Question: What does this figure show? Answer in one sentence.
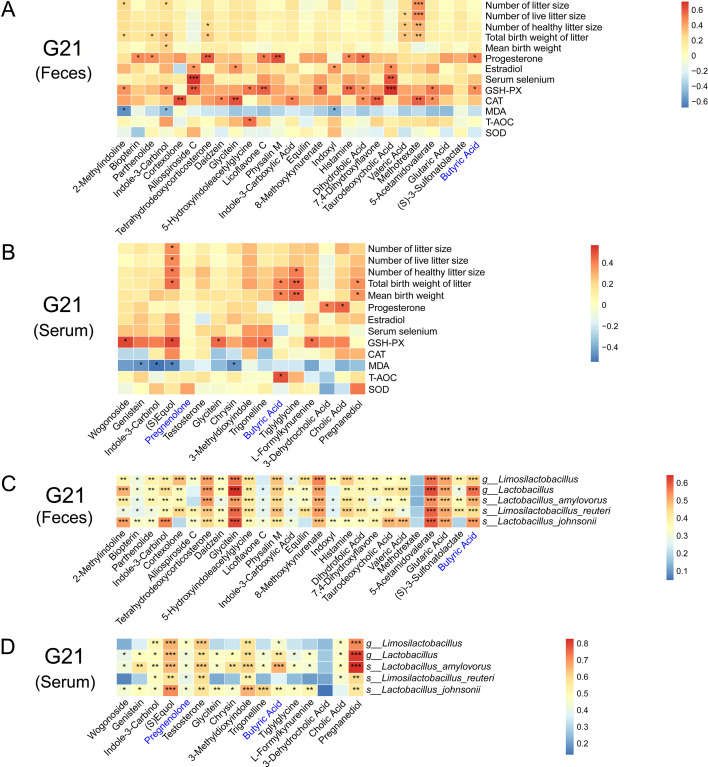
Answer: Correlations among metabolites, reproductive performance, selenium levels, reproductive hormones, antioxidant-related indicators, and intestinal microbiota. ( A ) Correlation among metabolites of fecal sample, reproductive performance, selenium levels, reproductive hormones, and antioxidant-related indicators on gestation day 21. ( B ) Correlation among metabolites of serum sample, reproductive performance, selenium levels, reproductive hormones, and antioxidant-related indicators on gestation day 21. ( C ) Correlation between intestinal microbiota and metabolites of fecal sample on gestation day 21. ( D ) Correlation between intestinal microbiota and metabolites of the serum sample on gestation day 21. Correlation coefficients were analyzed using Spearman correlation analysis. Red color indicates positive correlation, and blue color indicates negative correlation.